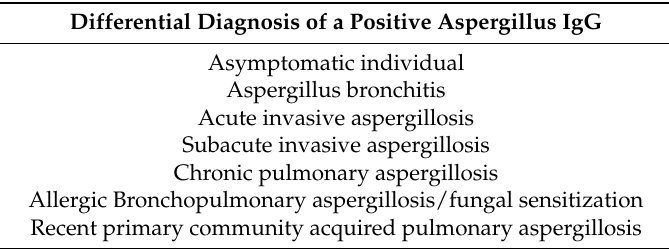
Table 4. Differential diagnoses for a patient with a positive Aspergillus